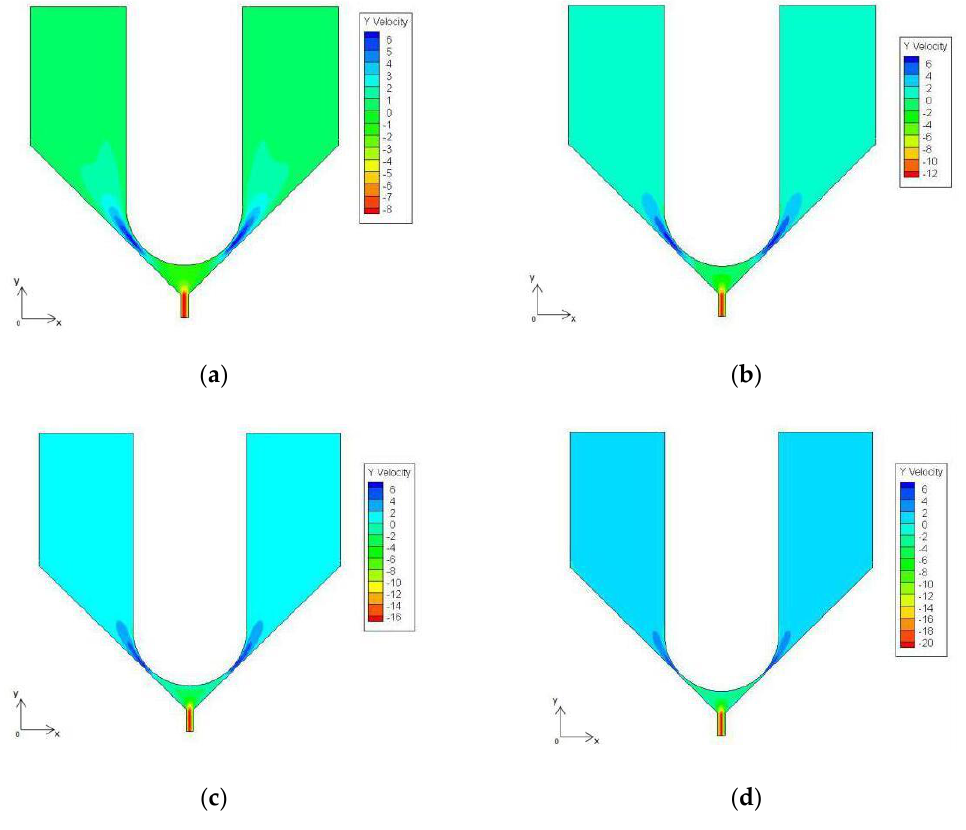
Figure 5. Velocity cloud at different times. ( a ) t1 = 2 × 10 −5 s; ( b ) t2 = 4 × 10 − 5 s; ( c ) t3 = 6 × 10 − 5 s; ( d ) t4 = 8 × 10 − 5 s.